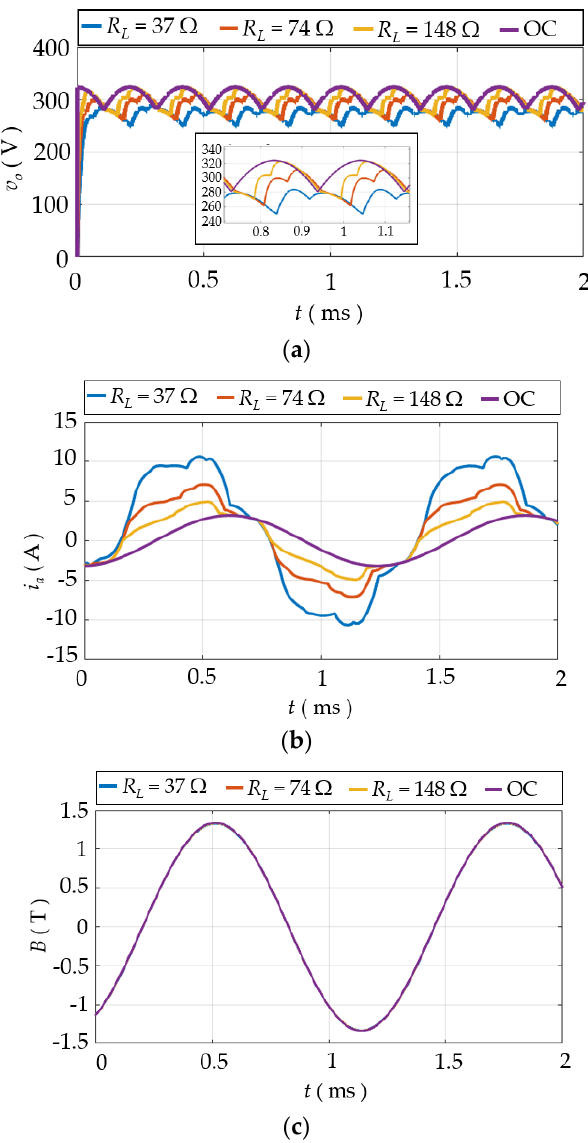
Figure 13. ATU Simulink/FEM simulation of a conventional 12-pulse rectifier. ( a ) Output voltage. ( b ) Input current. ( c ) Magnetic flux density. ( b ) Input current. ( c ) Magnetic flux density. Table 17. ATU output voltage simulation results under unbalanced input voltage.